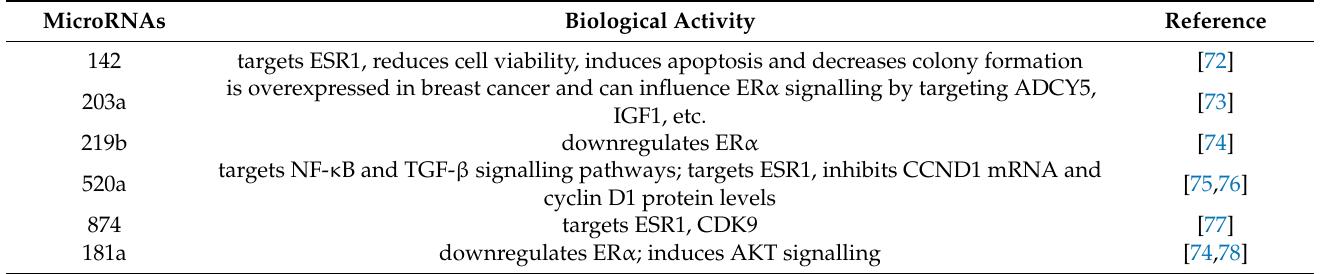
Table 1. List of the studied miRNAs and their